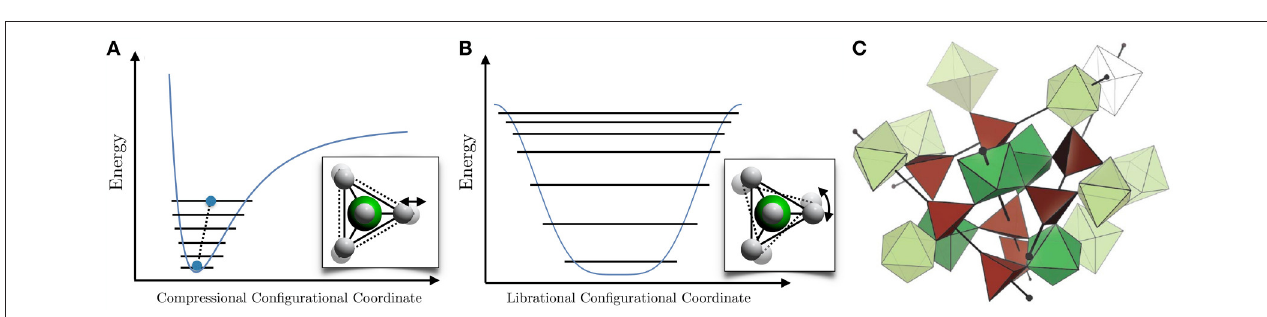
FIGURE 1 | Intermolecular potentials provide a heuristic explanation for the common occurrence of (A) PTE and (B) NTE. (C) The complex structure of the low-symmetry α -phase of ZrW 2 O 8 , from Hancock et al. (2004a).